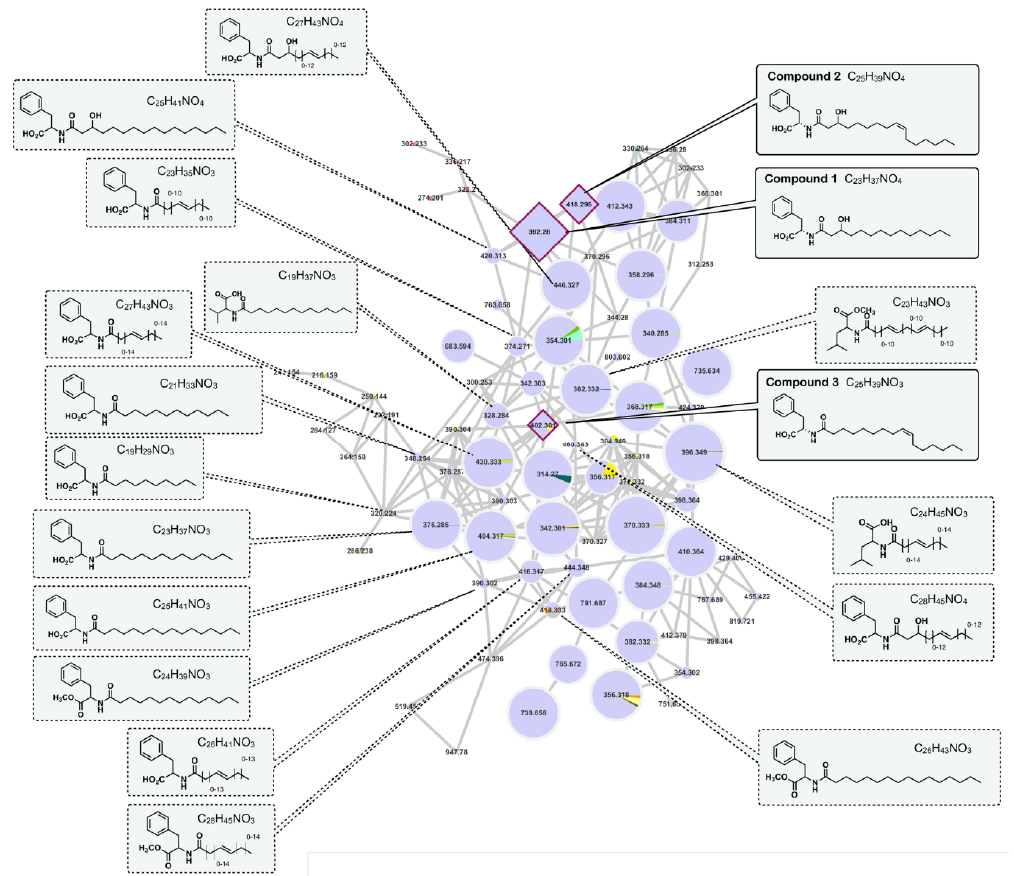
Figure 5. Cluster corresponding to hypothetic analogues of lipoamino acids putatively annotated through manual curation of their MSMS spectra.